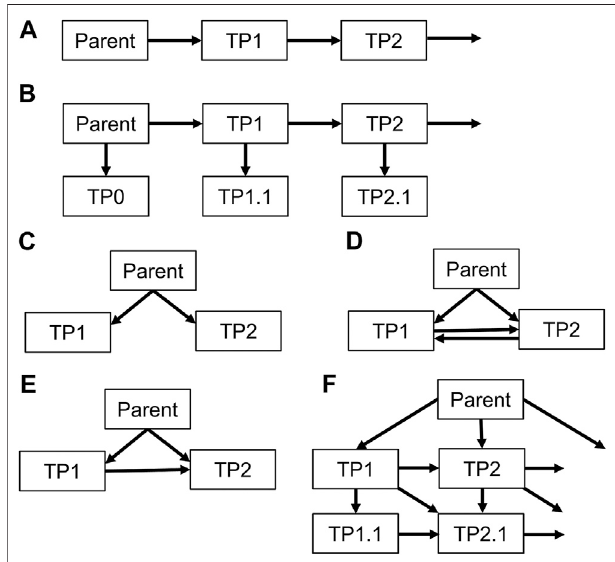
FIGURE 1 | Fixed transformation schemes implemented in investigated models. A: MACRO, RZWQM, LEACHM; B: GLEAMS, HYDRUS 1D, C: RZWQM; D: Zin-AgriTra; E: PRZM, FRM; F: Pelmo. PEARL and GeoPEARL contain totally fl exible